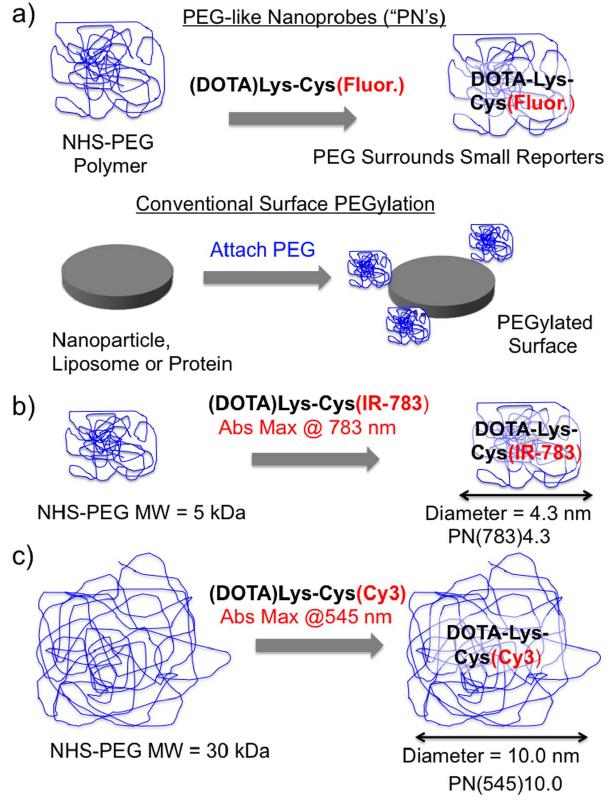
Figure 1. Reaction with PEG polymers and fluorochrome and DOTA bearing peptides yields PEG-like Nanoprobes (PN’s). A ) Syntheses of PEG-like Nanoprobe (PN’s). The peptide (DOTA)Lys- Cys(Fluor.), with an N-terminal DOTA, a variable fluorochrome (Fluor.) attached to the cysteine side chain, and a single primary amine, reacts with the NHS ester of a variable PEG. In the conventional PEGylations of proteins or nanoparticles, multiple PEG’s provide a PEG bearing surface. This approach yields materials with a PEG to protein ratio or with a PEG surface density. B ) Synthesis of the PN denoted PN(783)4.3. A 5 kDa PEG is reacted with the (DOTA)Lys-Cys(IR-783) peptide. The diameter (by FPLC) is 4.3 nm and the absorption maximum is 783 nm, hence PN(783)4.3. C ) A 30 kDa PEG is reacted with the (DOTA)Lys-Cys(Cy3) peptide. The diameter is 10.0 nm and an absorption maximum is 545 nm, hence, PN(545)10.0. A list of PN’s and their properties is given in Table 1.